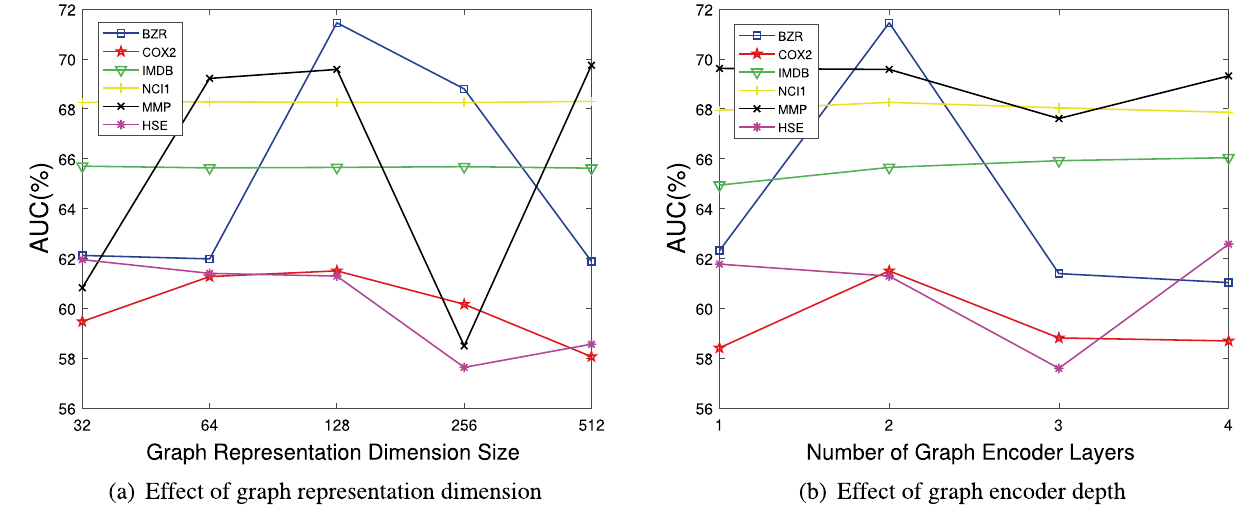
Figure 5. Parameter analysis for GLADC on six datasets w.r.t different values for graph representation dimension and graph encoder